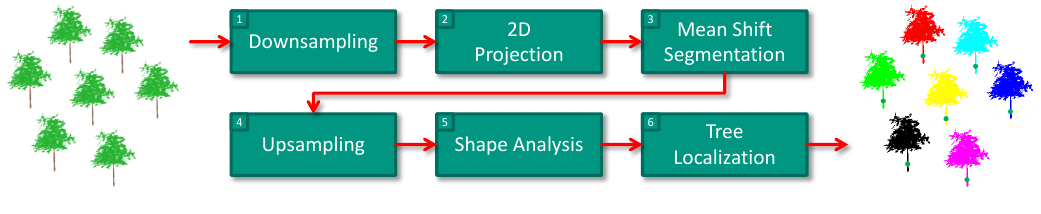
Figure 3. Illustration of the second step of our framework given by a semantic segmentation of “tree points” into segments corresponding to individual